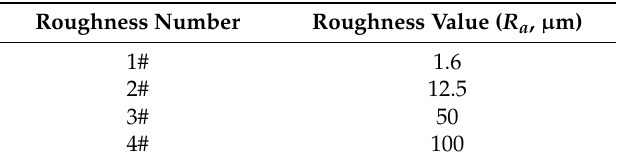
Table 3. Roughness of experimental